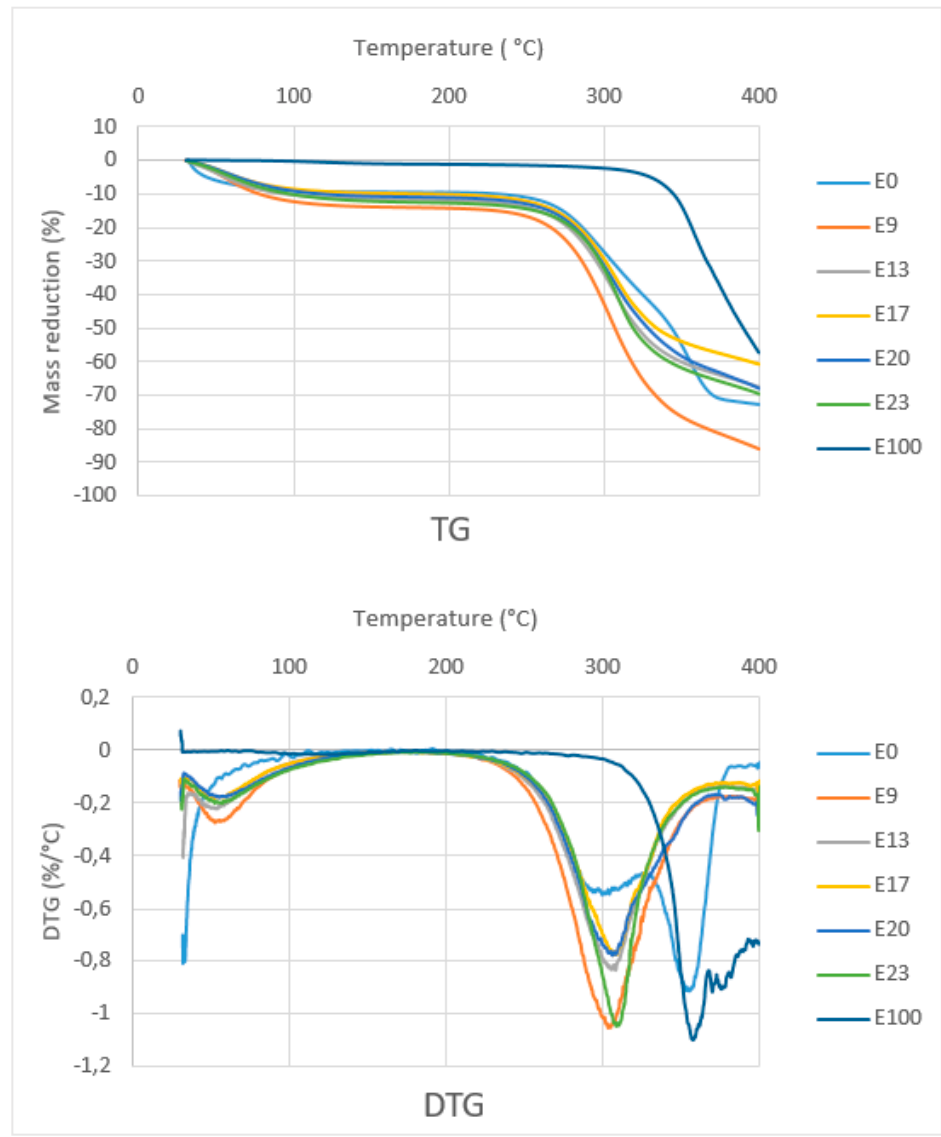
Figure 9. TG and DTG curves of sago fiber-epoxy composites, sago fiber, and epoxy resin.